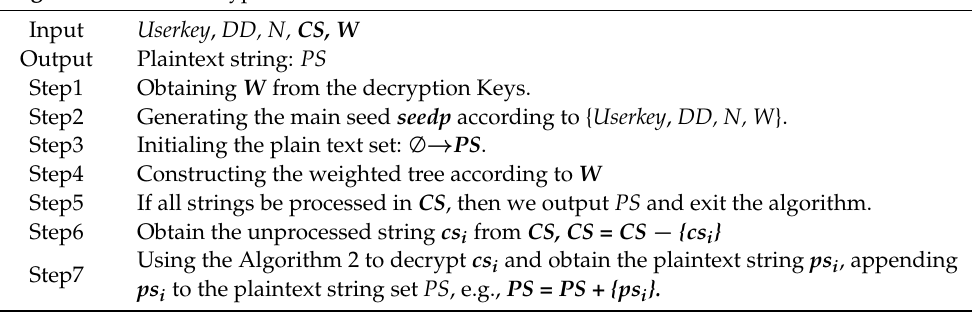
Algorithm 4: The decryption scheme of